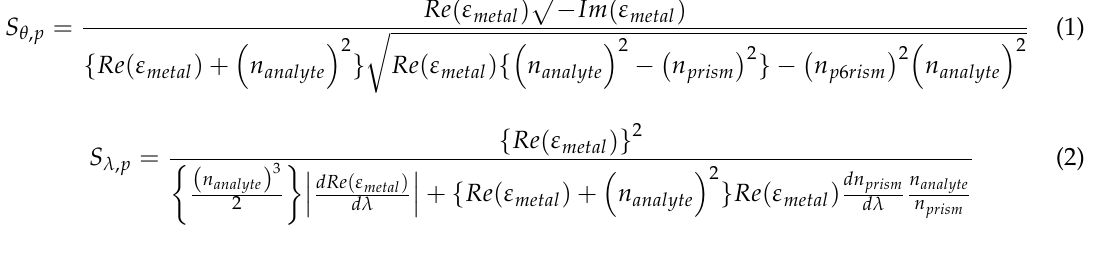
Figure 1. ( a ) Schematic of a prism-based SPR sensor with the Kretschmann configuration; ( b ) schematic illustration of the principle of a prism-based SPR immunoassay to determine concentrations of cardiac troponin T (reproduced from [46] with permission from Elsevier); ( c ) Schematic of a diffraction grating-based SPR sensor; ( d ) a miniaturized, diffraction grating-based SPR sensor for highly sensitive refractive index estimation of the specimen above the grating (reproduced from [47] with permission from Elsevier); ( e ) schematic of a fiber-based SPR sensor; ( f ) a fiber-based SPR sensor that is compatible with a commercial syringe needle to detect DNA hybridization processes and a prototype of an automatic multi-sample DNA hybridization instrument with the integration of computer-controlled sensor positioning stages (reproduced from [48] with permission from Elsevier).